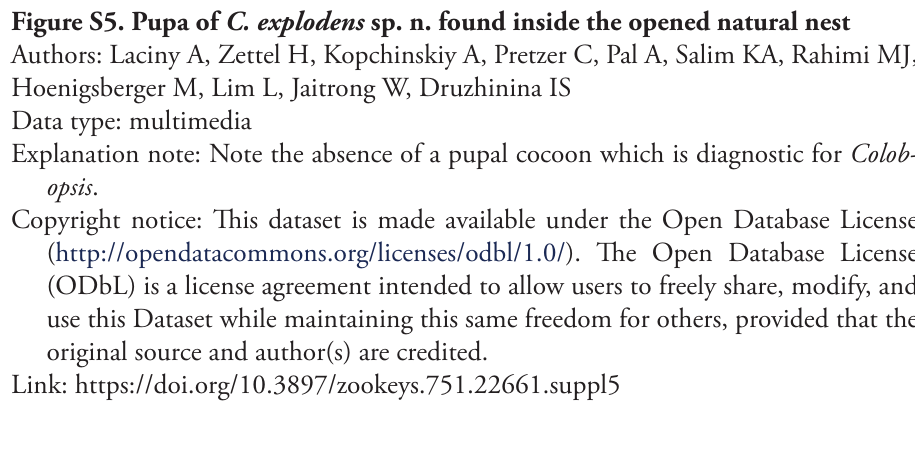
Figure S5. Pupa of C. explodens sp. n. found inside the opened natural